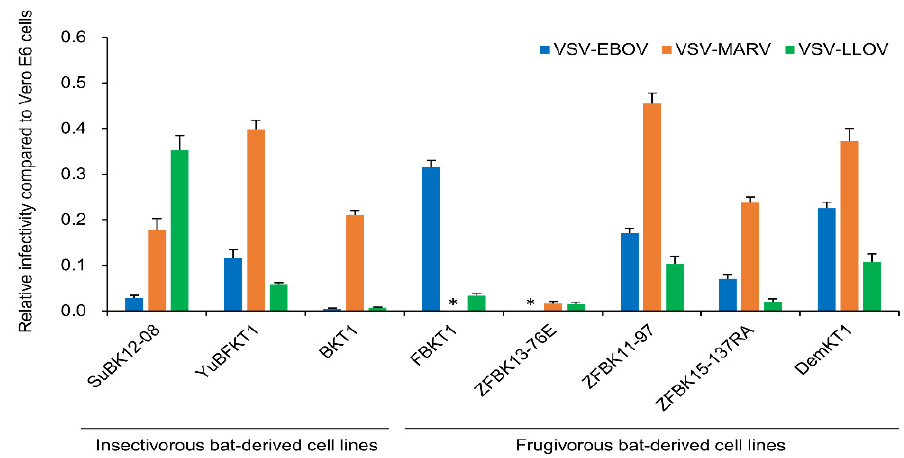
Figure 1. Susceptibilities of bat-derived cell lines to vesicular stomatitis virus (VSV) pseudotyped with filovirus glycoproteins (GPs). Vero E6 and bat-derived cells were infected with VSVs pseudotyped with filovirus GPs (VSV–Ebola virus (EBOV), –Marburg virus (MARV), and –Lloviu virus (LLOV)). The relative infectivity of pseudotyped VSVs in bat-derived cell lines, compared to Vero E6 cells, was determined as described in Section 2. Each experiment was conducted three times, and average and standard deviations are shown. Asterisks represent IUs under the limit of detection (20 IU/mL).